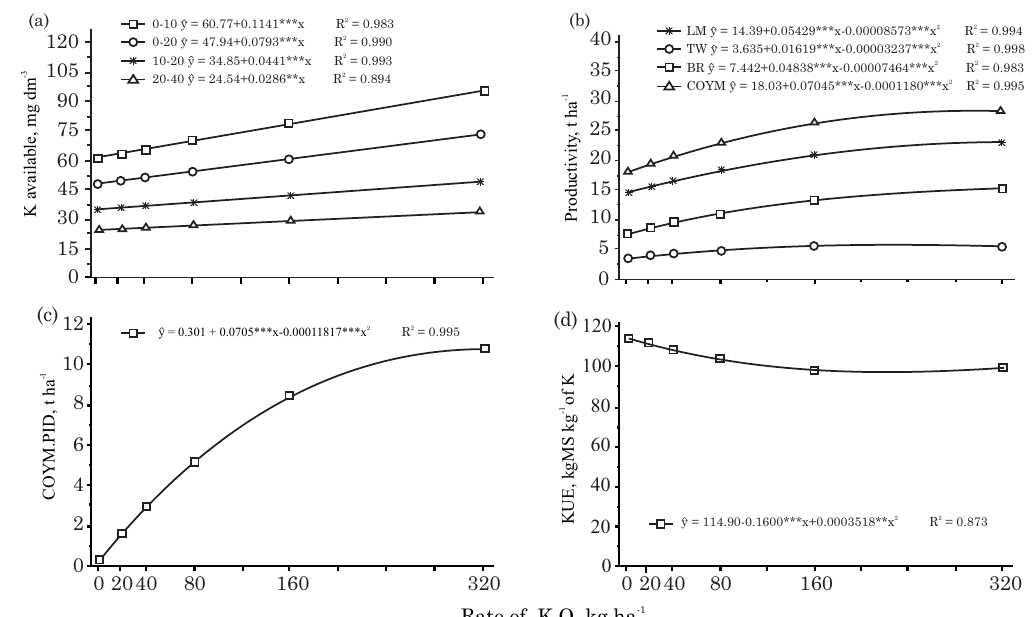
Figure 1. Availability of K in the soil in the layers 0-10, 0-20, 10-20, and 20-40 cm (a); fresh leaf matter yield (LM), twigs (TW), thick branches (BR) and commercial yerba mate (COYM) (b); COYM yield affected by the rate (COYM.PID) (c); and K use efficiency (KUE) in K-fertilized yerba mate (d). ** and *** significant at 1 and 0.1 %,